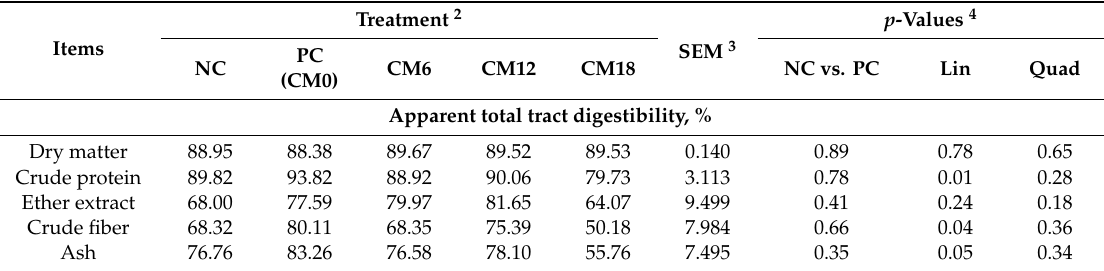
Table 6. E ff ects of copra meal (CM) inclusion level in the diet with β -mannanase on apparent total tract digestibility of growing pigs 1